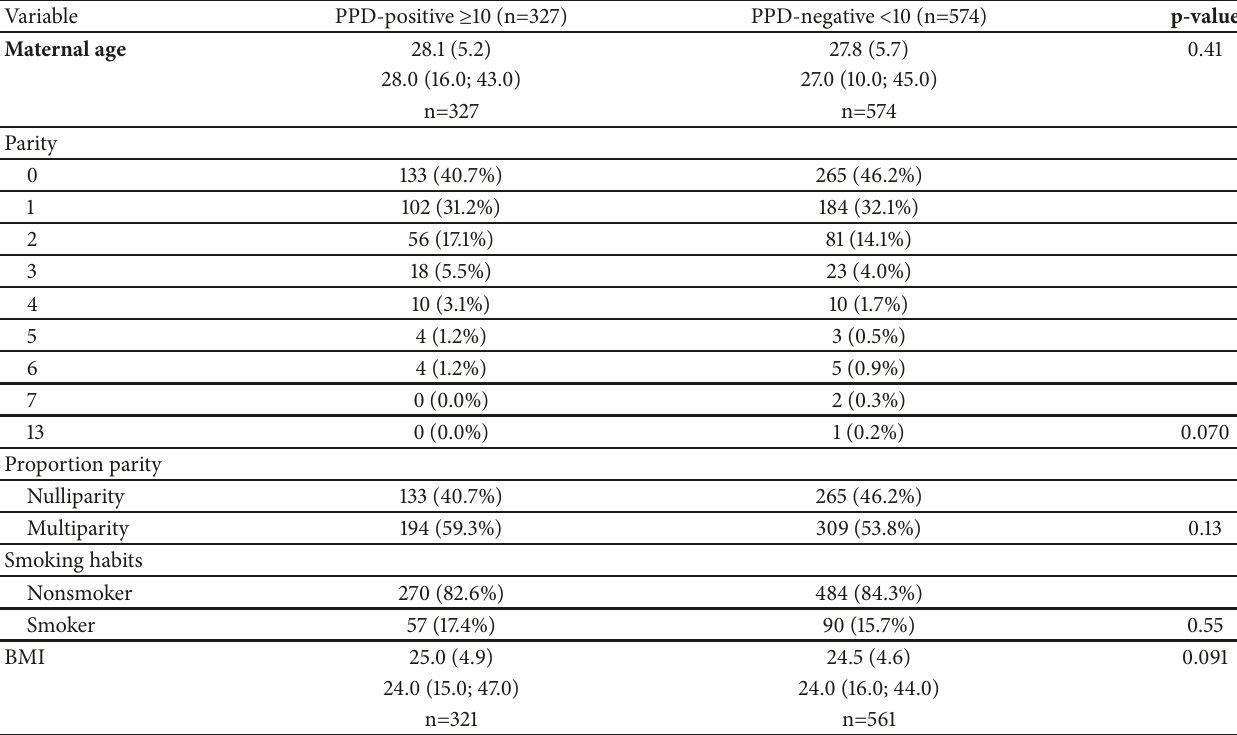
Table 1: Baseline